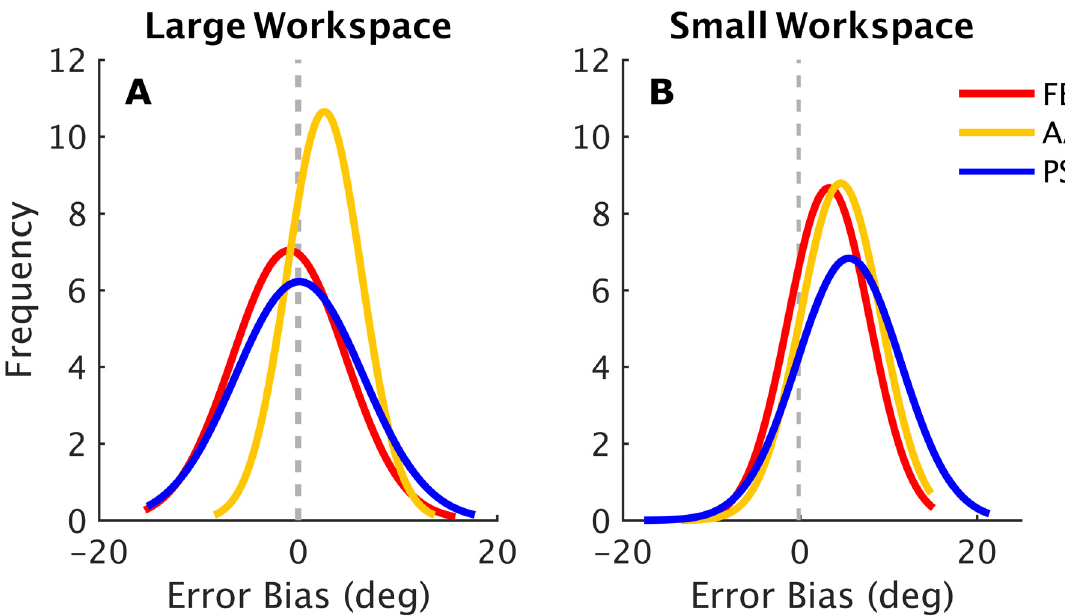
Fig 3. Probability density distributions for the error bias of all the three DoFs in the large (A) and the small (B) workspace. A distribution shifted to the left indicates subjects ’ tendency of undershooting, vice versa, a distribution shifted to the right, representing predominance of positive error biases , indicates a predominant tendency of target overshooting.